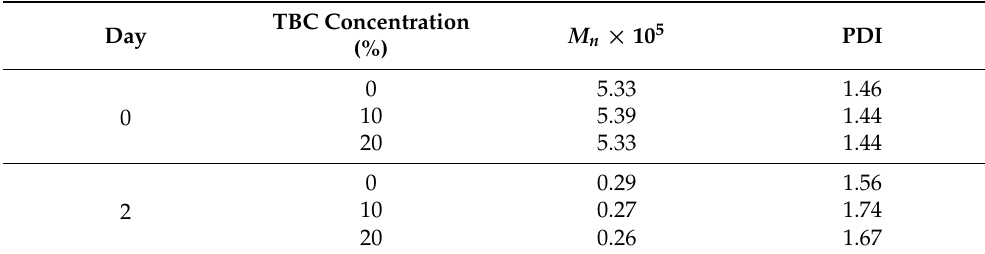
Table 3. Comparison of molecular weight change before and after degradation by Microbulbifer sp. SOL66 according to the addition of 0%, 10%, and 20% of tributyl citrate.